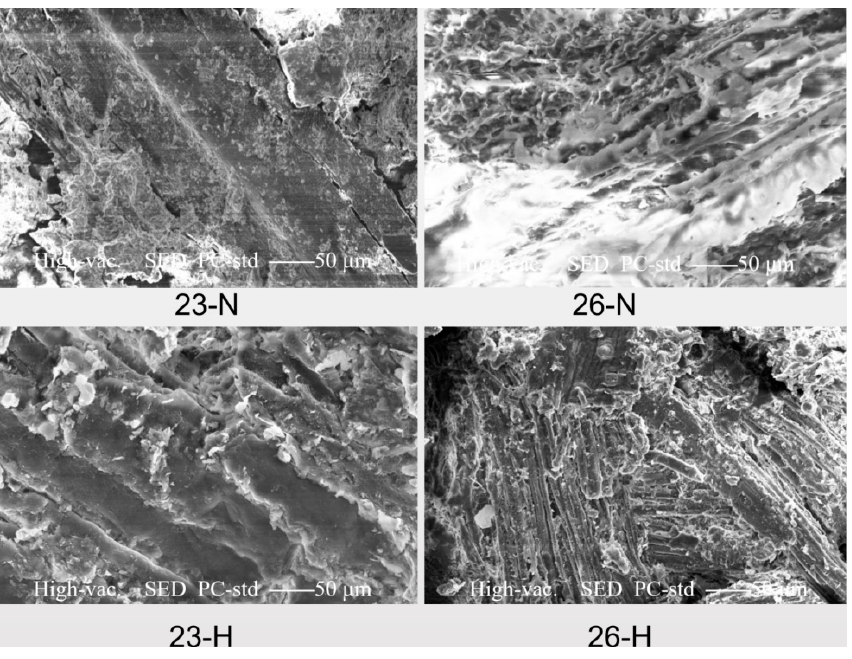
Figure 12. SEM images of seedling trays after seedling raising.